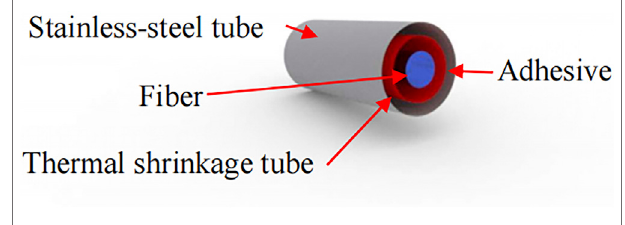
FIGURE 3 | FBG strain sensor with thermal shrinkage insert.